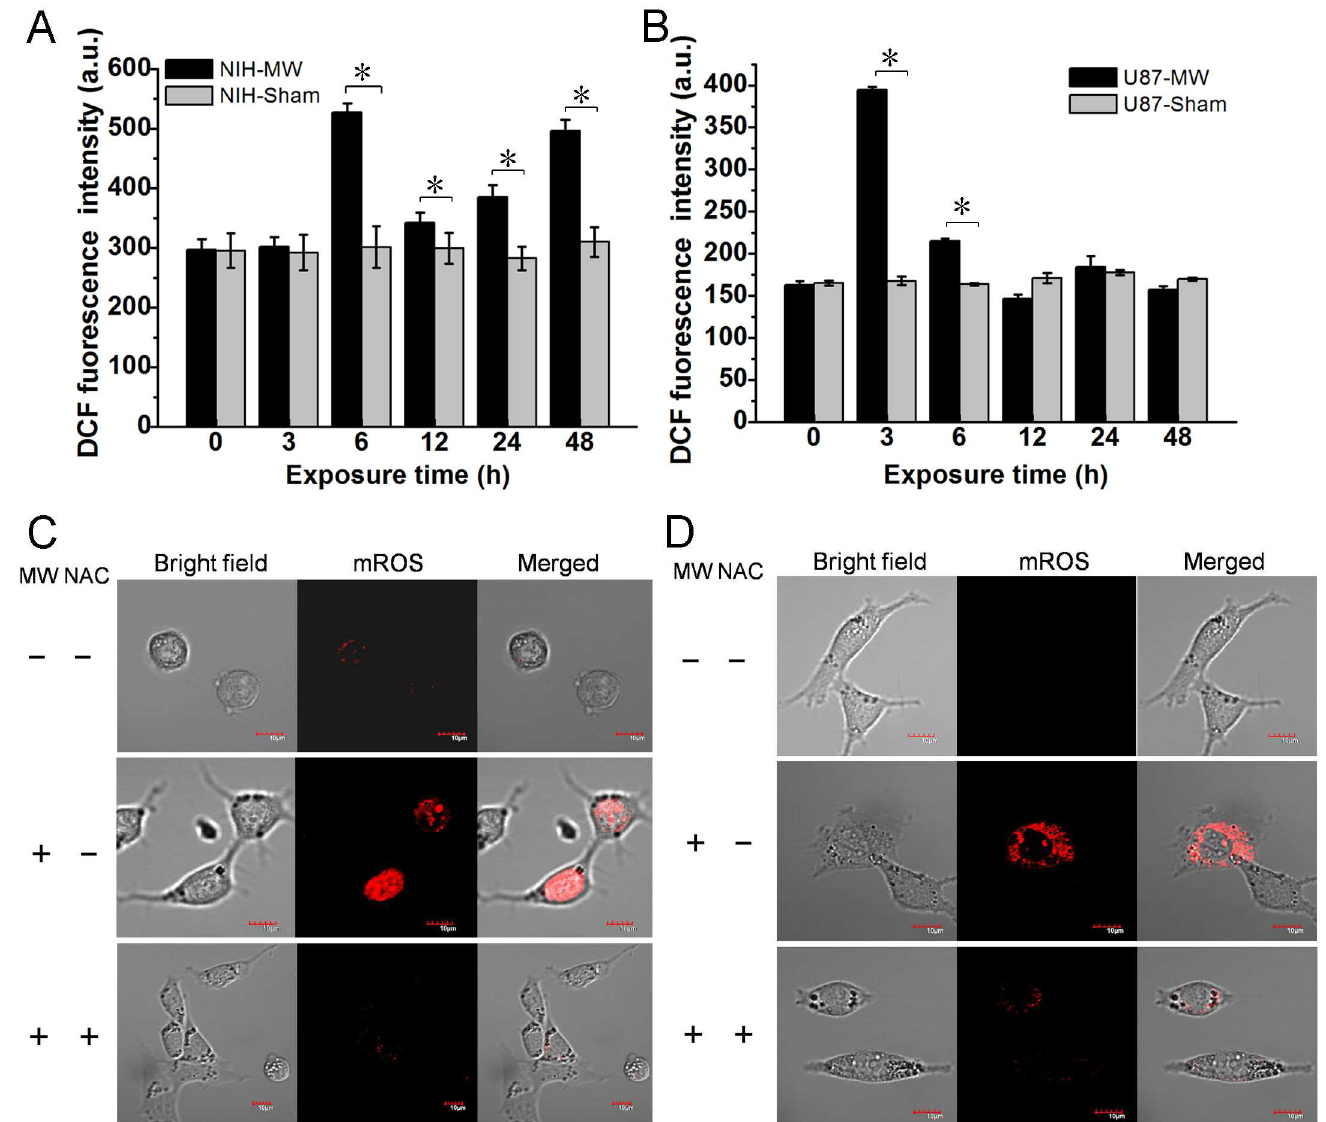
Fig 3. Exposure to 1800MHz microwave induces ROS production in NIH/3T3 and U-87 MG cells. (A, B) Intracellular ROS productionwas measured by using DCFH-DA after 1800MHzmicrowave radiation for the indicatedtime in NIH/3T3 and U-87 MG cells. (C, D) detection